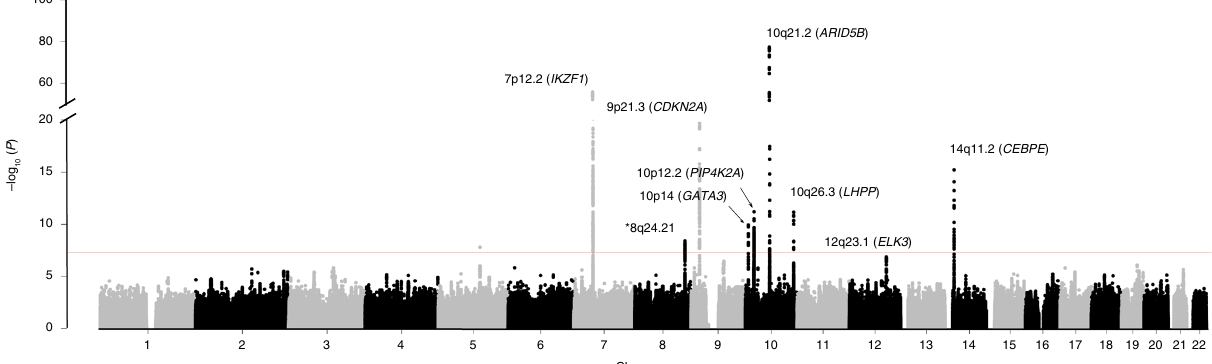
Fig. 1 Manhattan plot of association. y -axis shows genome-wide P -values (two-sided, calculated using SNPTEST v2.5.2 assuming an additive model) of >6 million successfully imputed autosomal SNPs in 2442 cases and 14,609 controls. The x -axis shows the chromosome number. The red horizontal line represents the genome-wide signi fi cance threshold of P = 5.0 × 10 −